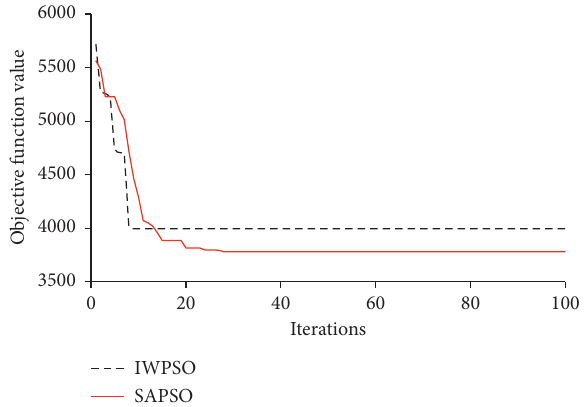
Figure 14: Convergence curve for the basic PSO and the